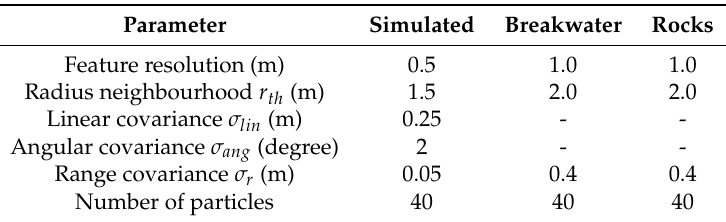
Table 1. Parameters used in the different datasets. On the real datasets prediction covariances are gathered from the covariance matrix P ekf k